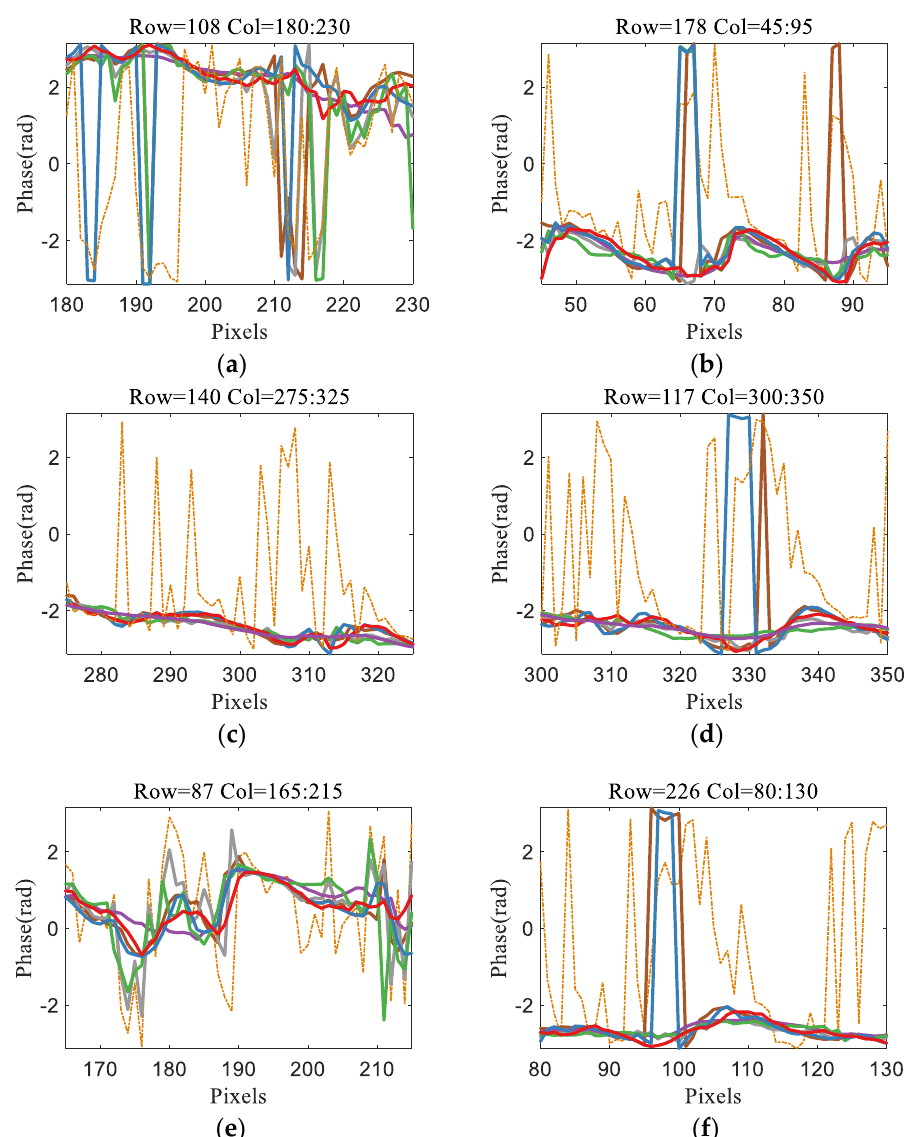
Figure 21. The filtered phase profiles with OLCP-InSAR and other reference filtered methods operating on the matrix model. ( a ) The filtered phase profiles at row 108 and column 180 to 230. ( b ) The filtered phase profiles at row 178 and column 45 to 95. ( c ) The filtered phase profiles at row 140 and column 275 to 325. ( d ) The filtered phase profiles at row 117 and column 300 to 350. ( e ) The filtered phase profiles at row 87 and column 165 to 215. ( f ) The filtered phase profiles at row 226 and column 80 to 130.